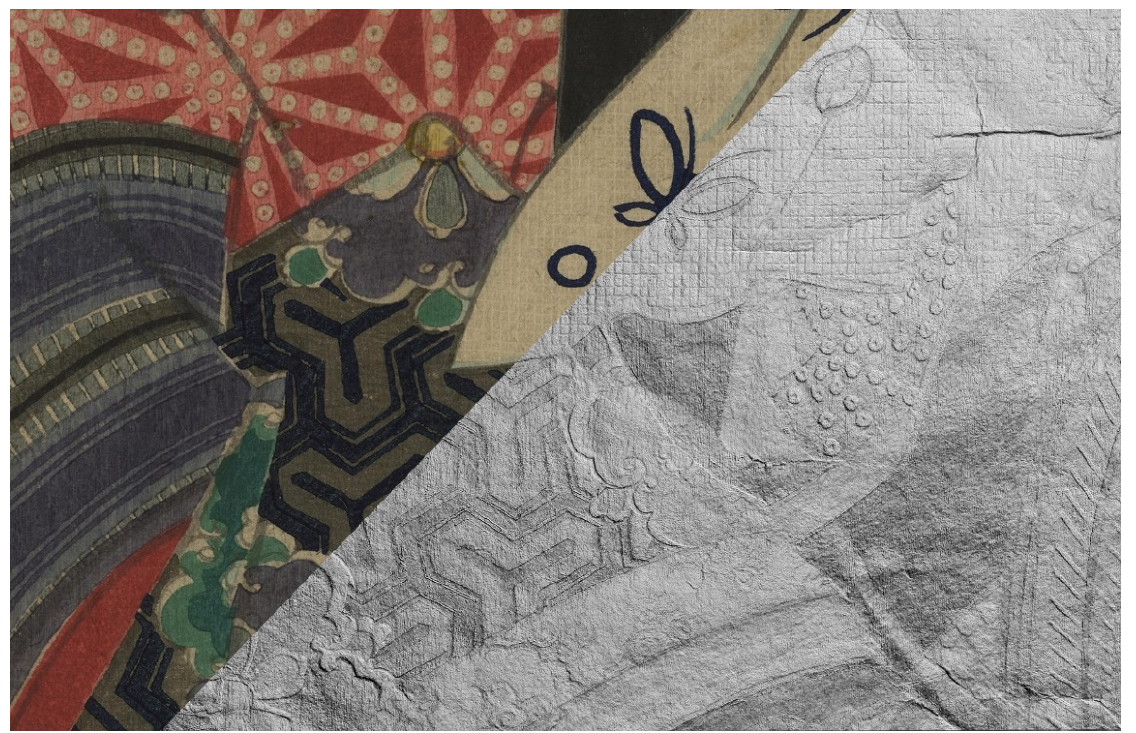
Figure 4. RTI detail of print 4 showing the embossed features, as a result of the different printing techniques, compared to the visible image.